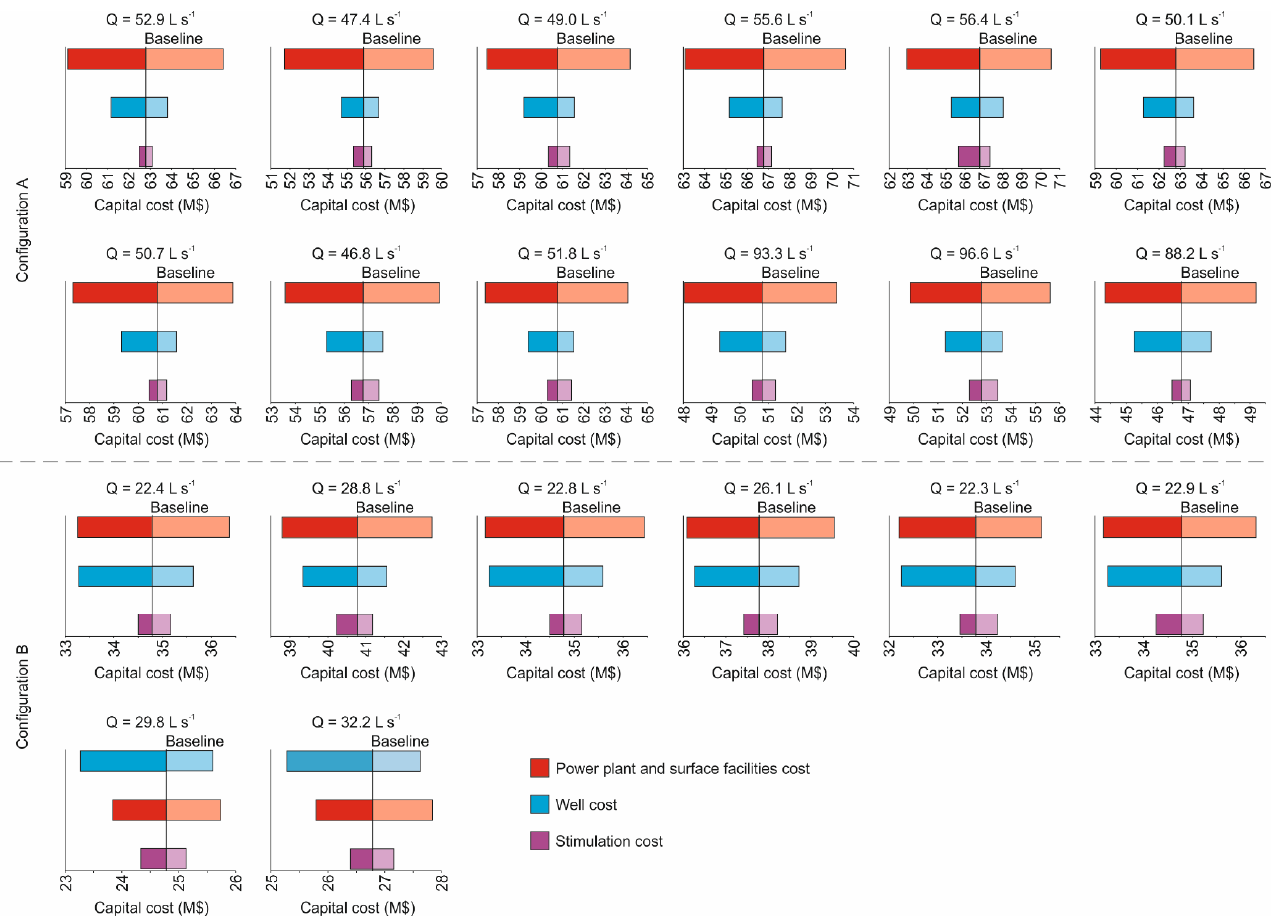
Figure 16. Input parameters ranked according to their influence on the capital cost. Baseline—overall simulated mean value, solid color—positive impact on the output, transparency—negative impact on the output. The cost is in USD. The reader is referred to Tables 4 and 5 for further details on the flow rates.